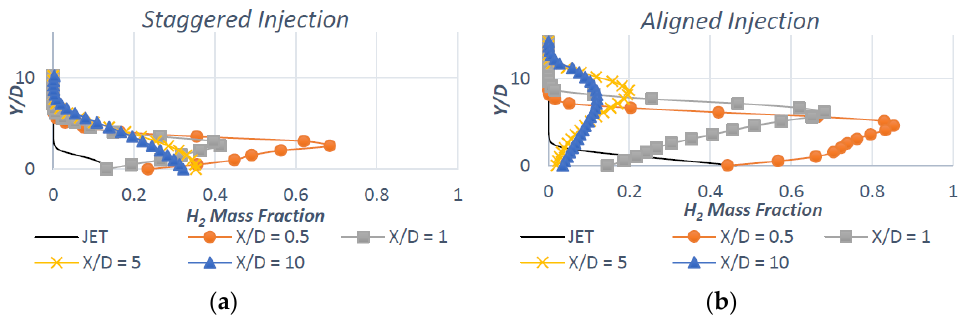
Figure 21. ( a ) Staggered jet penetration height; ( b ) Aligned jet penetration height.